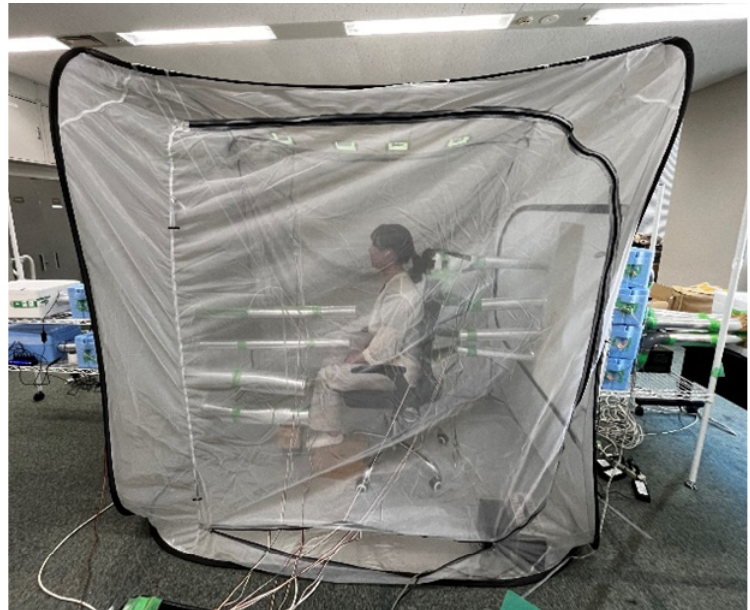
Figure 9. Verification experiment environment.